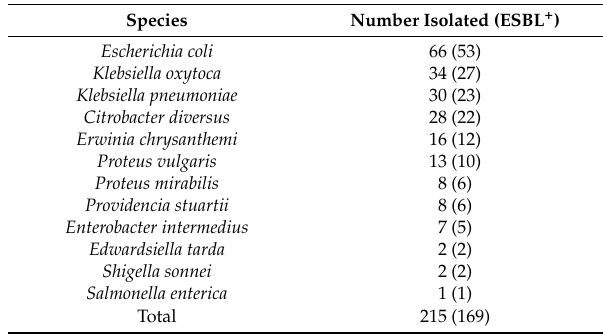
Table 1. Species composition of ESBL + enterobacteria from